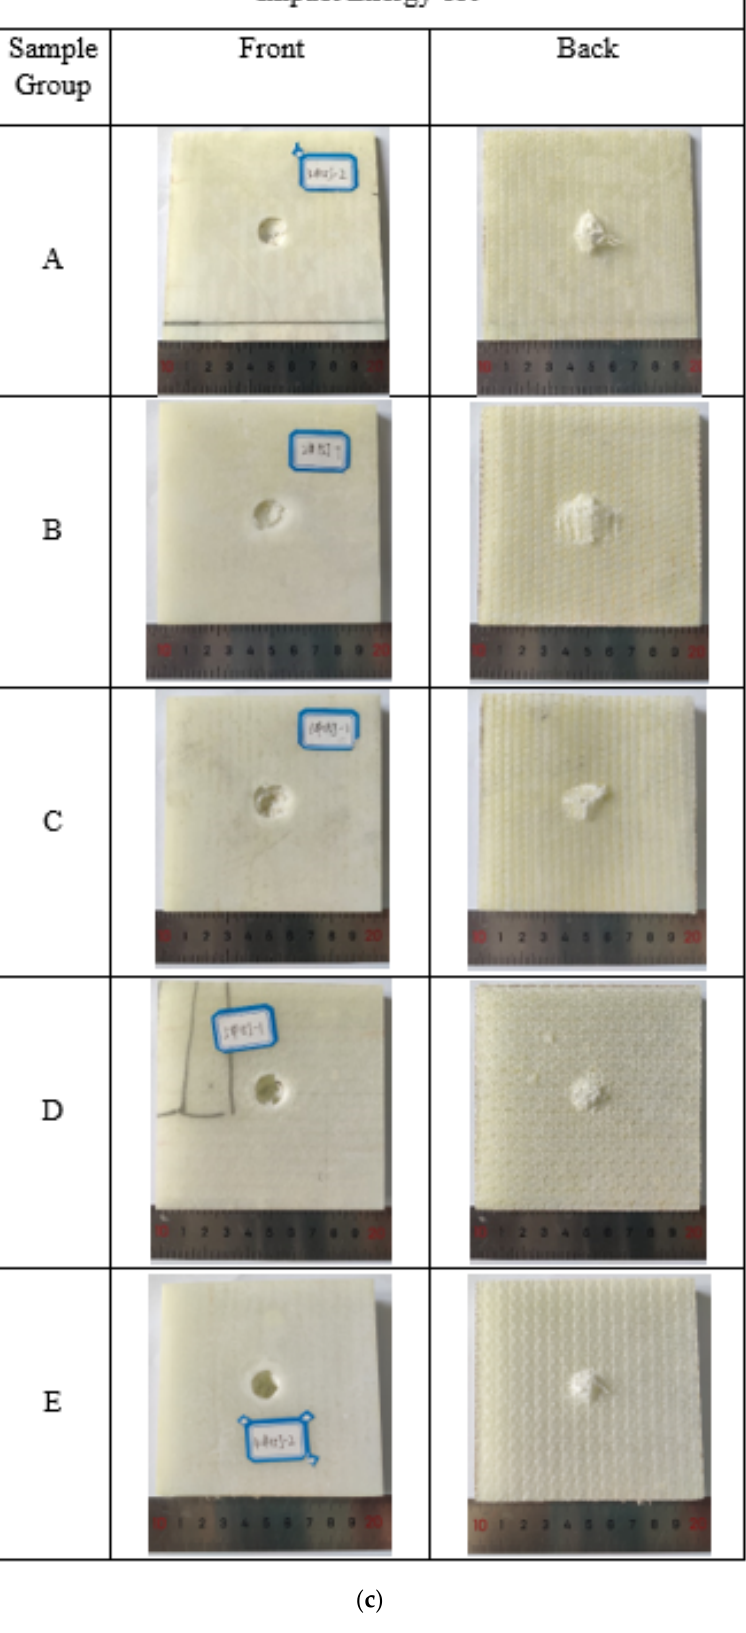
Figure 6. Impact damage samples under impact energies ( a ) 5 J, ( b ) 10 J, and ( c ) 15 J.